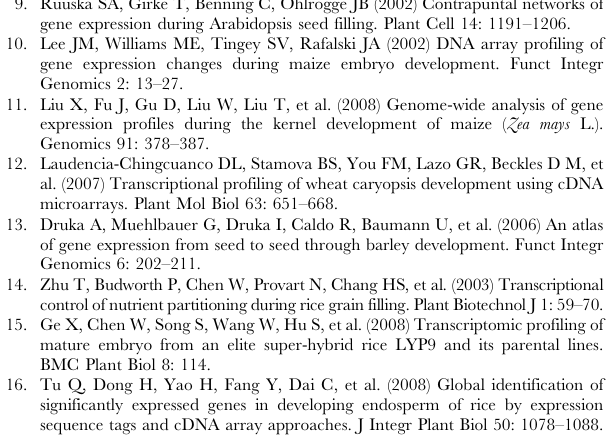
Figure S1 Numbers of genes expressed during seed Figure S2 Validation of microarray data. Expression pattern of genes regulated in embryo (A) and endosperm (B) of cultivar Nipponbare are compared with the trends in Zhonghua 11 (ZH). The left vertical bars indicate the individual gene is up- regulated (yellow) or down-regulated (blue) in ZH. ‘‘D’’ indicates days after fertilization (DAF). The data for heatmap were normalized by gene, and the value scale is shown at the bottom. The data of cultivar Nipponbare were from Gene Expression Omnibus (GSE21494). Figure S3 Genes involved in starch (A) and lipid (B) metabolism. Genes are predominantly expressed in embryo (red), endosperm (blue) or both embryo and endosperm (black) are indicated. The annotations of genes are from MAPMAN (http:// mapman.gabipd.org). Figure S4 Expression patterns of genes involved in hormone biosynthesis and signaling during embryo (A) or endosperm development (B). The average data of two replicates are calculated, and normalized in Z-score. TIGR MeV was used for visualization. Table S1 Reproducibility of microarray data of each tissue. ‘‘PCC’’ indicates Pearson correlation coefficient of data from the entire array. ‘‘ZH’’ or ‘‘HF’’ indicates the whole seed of Zhonghua 11 or Hanfeng respectively. ‘‘C’’ indicates the low temperature treatment (14 u C) for 48 h, ‘‘D’’ indicates days after fertilization (DAF). Refer to Materials and Methods section for details. Table S2 Transcription factors associated with seed development. The TF numbers of each family are shown. ‘‘Em’’ or ‘‘En’’ indicates the genes predominately expressed in embryo or endosperm, respectively. ‘‘Both’’ indicates that genes are predom- inately expressed in both embryo and endosperm; ‘‘Em_T’’ or